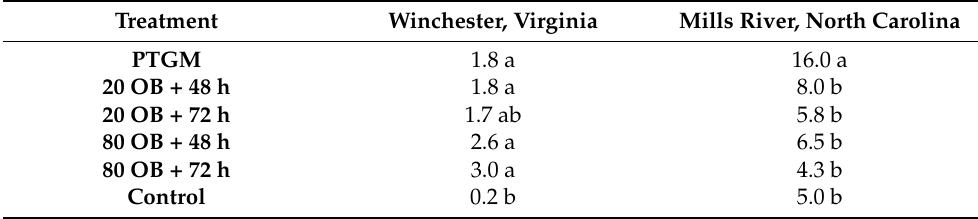
Table 7. Treatment effect on phytotoxicity z, y.